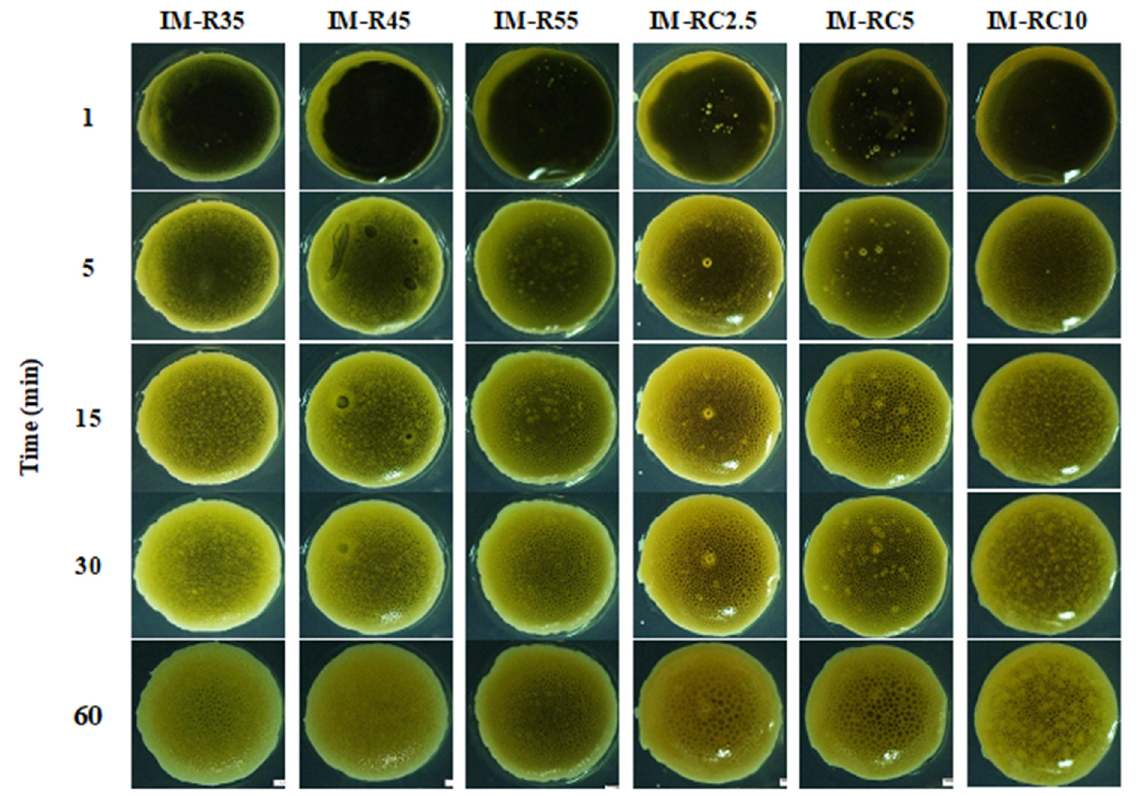
Figure 3. Gel formation of the IM-loaded rosin/CO-based ISG formulations after contact with agarose gel at different time intervals under using a stereomicroscope.